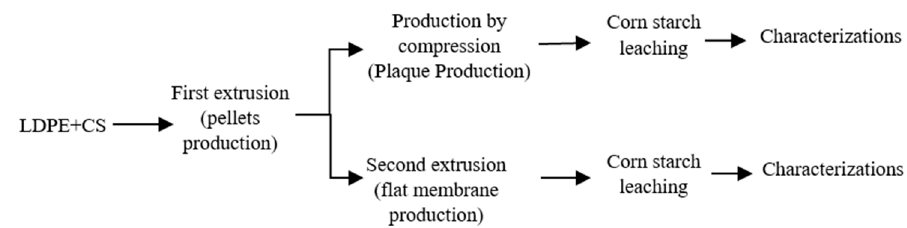
Figure 1. Schematic diagram of the membrane preparation and characterization steps.